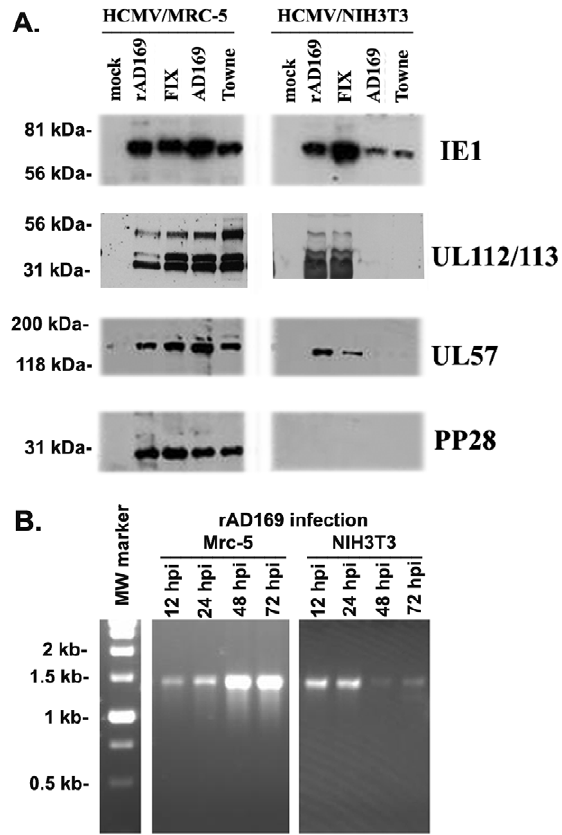
Figure 4. Detection of HCMV proteins and DNA after infection in NIH3T3 and Mrc-5 cells. A . Western blot assay to detect HCMV protein production: Whole-cell lysates were prepared at 48 hr after the infection of different strains of HCMV in MRC-5 cells (left) and NIH3T3 cells (right); after being run on PAGE gels, the proteins were transferred and detected with specific antibodies. Detected HMCV proteins are indicated on the right. B . PCR to detect HCMV DNA replication: Using a modified Hirt method (7), viral DNA was prepared from MRC-5 cells (left) or NIH3T3 cells (right) at the indicated post-infection times. PCR was performed using the primers (described in the Material and Methods) and PCR products were run on an agarose gel in order to visualize the DNA (using a UV